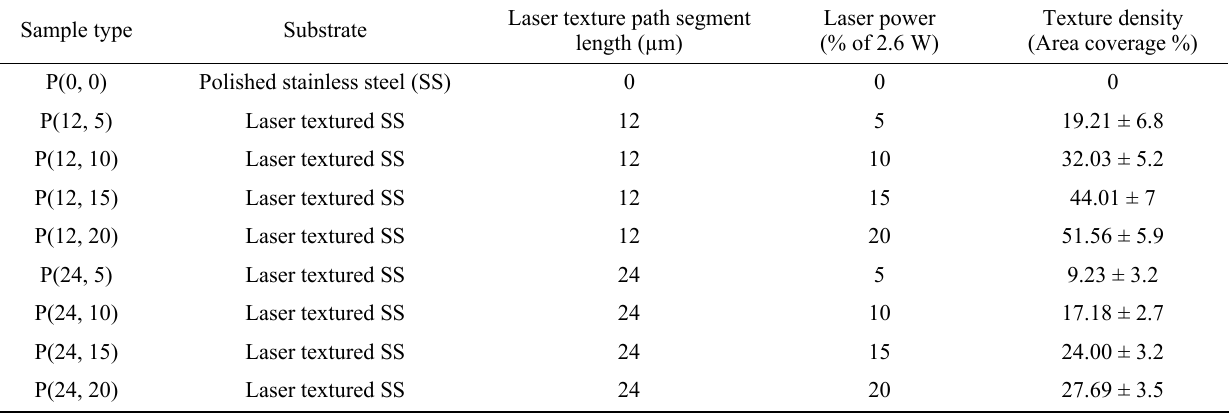
Table 1 Sample types with different texture path segment lengths and different laser power having different texture densities. All samples were textured with a laser frequency of 600 Hz and an R. A. divider of